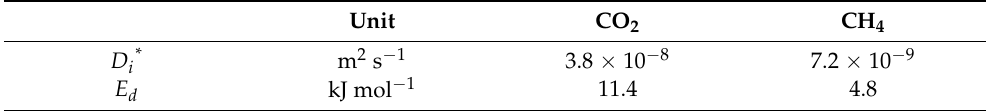
Table 3. Diffusivities at infinite temperature and activation energies of CO 2 and CH 4 within CHA- type zeolite with Si/Al =